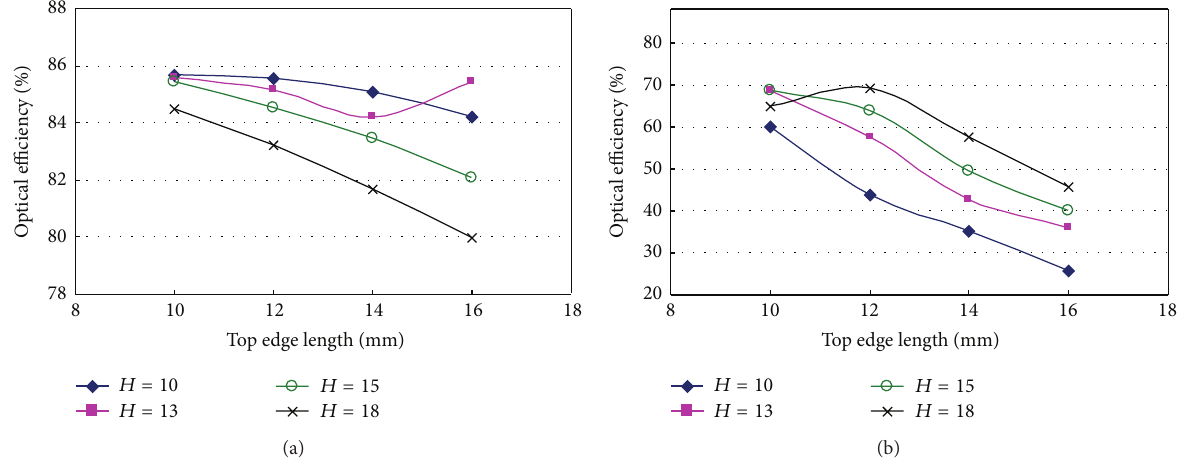
Figure 4: Effects of reflective pyramid SOE parameters on the optical efficiency: (a) incidence angle = 0 ∘ (normal incidence) and (b) incidence angle = 1 ∘